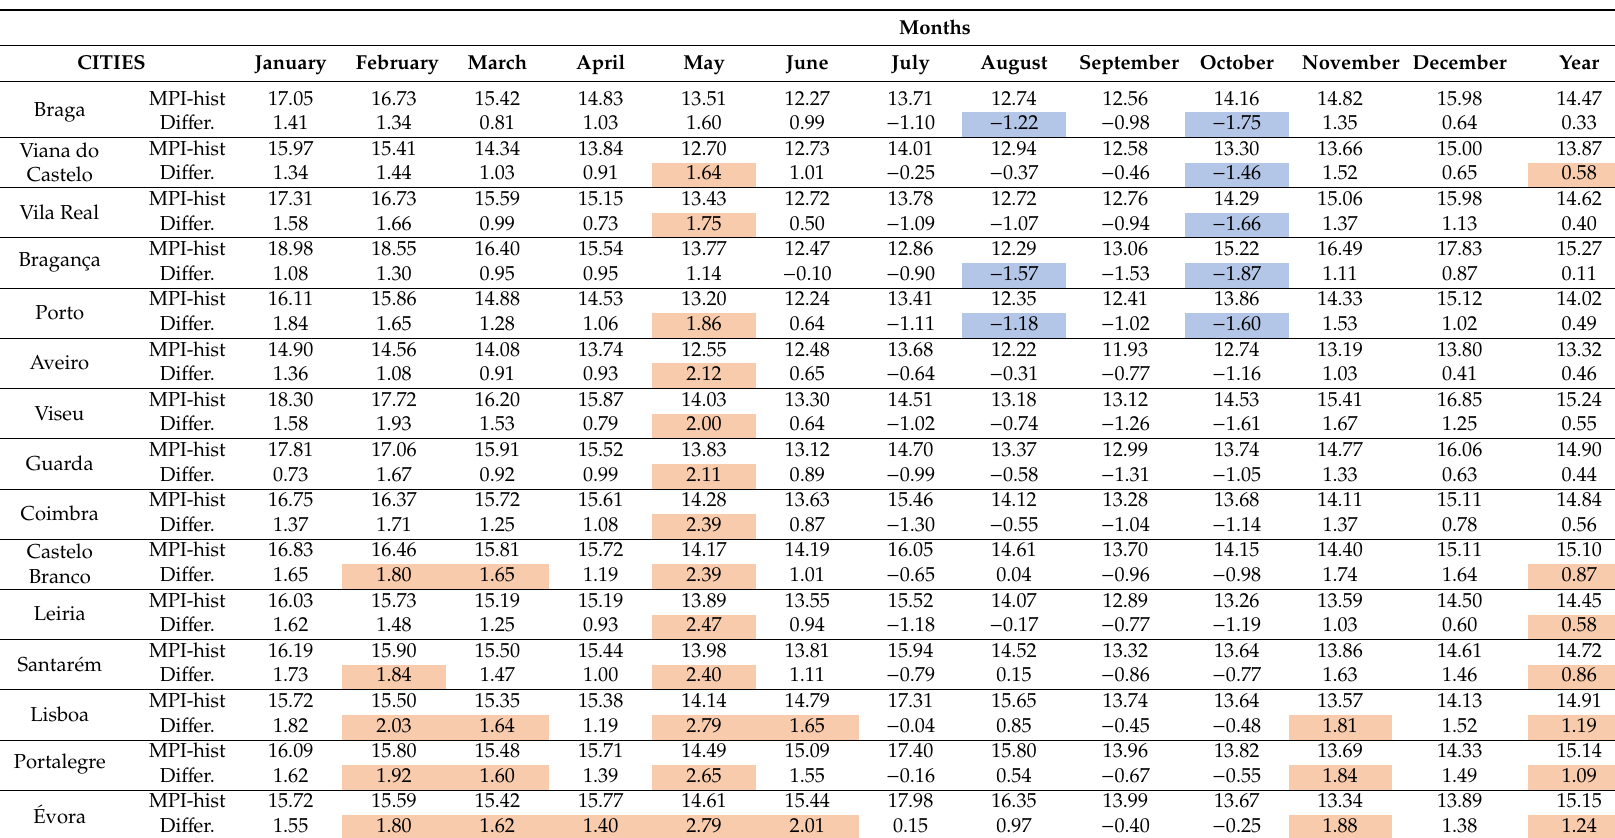
Table 8. Monthly and annual averaged wind shear 0–6 km for each city and the di ff erence between the future and the historical climates. Significant di ff erences ( t -student 5%) are shown in red (positive) and blue